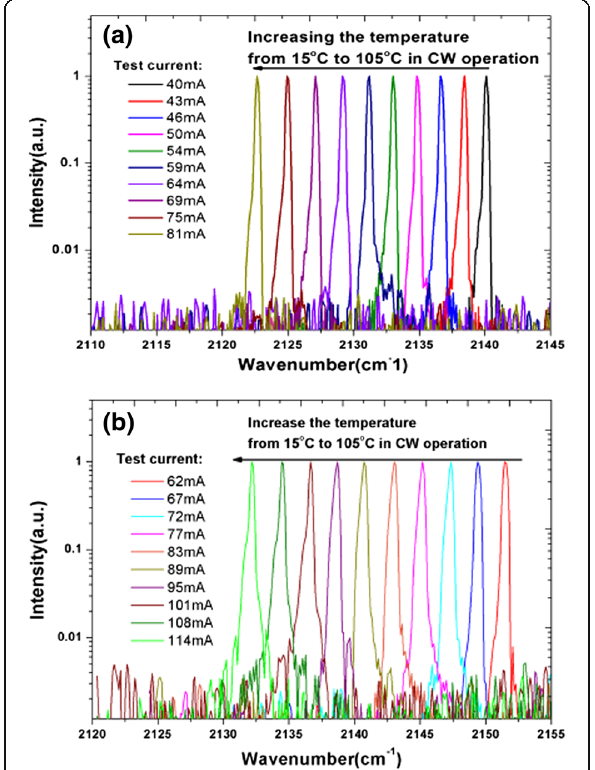
Fig. 2 The L-I-V characteristics of the 1 mm ( a ) and 0.5 mm Fig. 3 The lasing spectra of the a 0.5 and b 1 mm